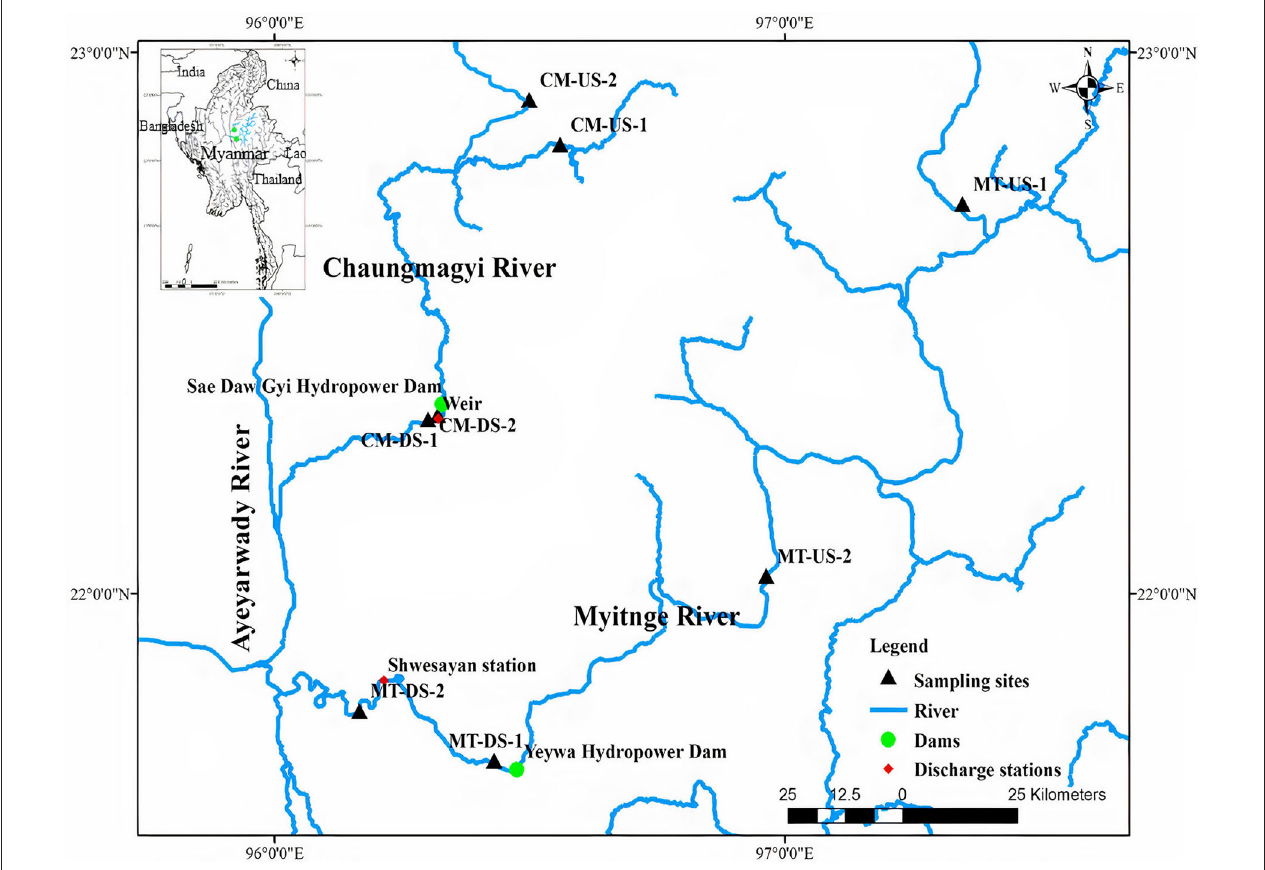
FIGURE 1 | Locations of the sampling sites upstream and downstream of the two hydropower dams (US, upstream; DS, downstream) on Myitnge (MT) and Chaungmagyi (CM) Rivers.